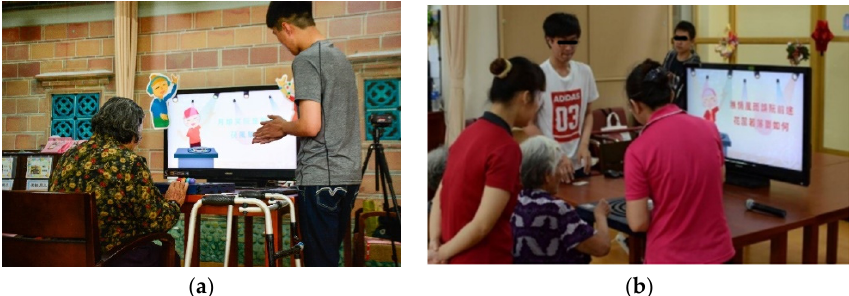
Figure 5. Scenes of the first field experiment. ( a ) A staff member of this study explaining the interaction process to a participating older adult. ( b ) Three staff members assisting a participating older adult to use the interactive device.